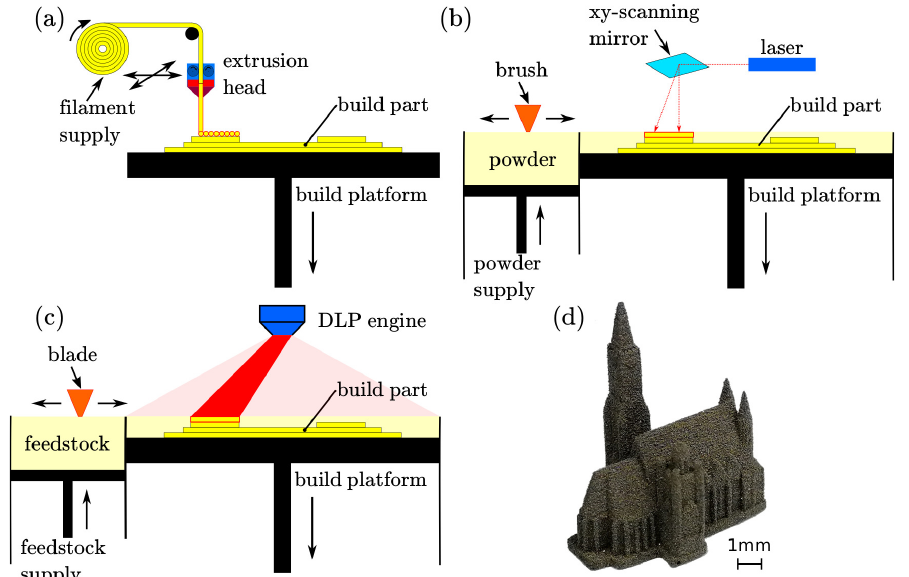
Figure 1. Different used additive manufacturing (AM) methods. ( a ) fused filament fabrication (FFF). ( b ) selective laser sintering (SLS). ( c ) stereolithography (SLA). ( d ) 3D printed magnetic St. Stephen’s Cathedral, Vienna by